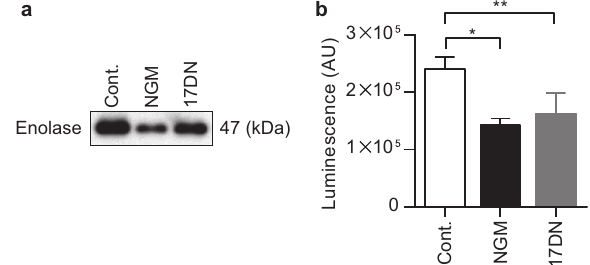
Fig. 3 The effects of NGM on enolase expression in the ECM. a Western blotting analysis of enolase expression in the ECM using an anti-enolase antibody. b Band intensities of western blotting analysis of enolase expression in the ECM. Data are presented as the mean ± SD ( n = 3). * p < 0.01, ** p <